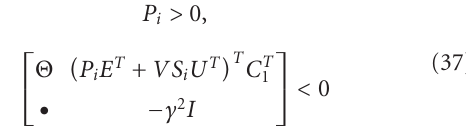
Algorithm 14. It is constructed by using the LMI constraints: